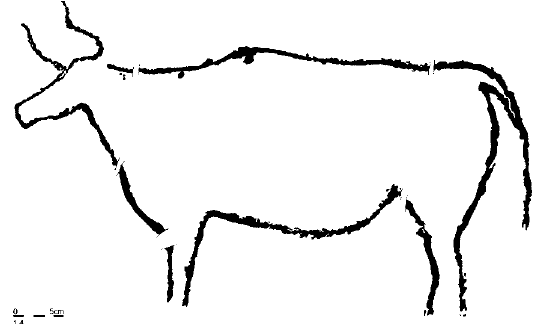
Figure 2. Canada do Inferno Rock 26, Côa Valley, Portugal. Horse depiction. Tracing: Fernando Barbosa, assisted by Manuel Almeida and António Martinho Baptista.